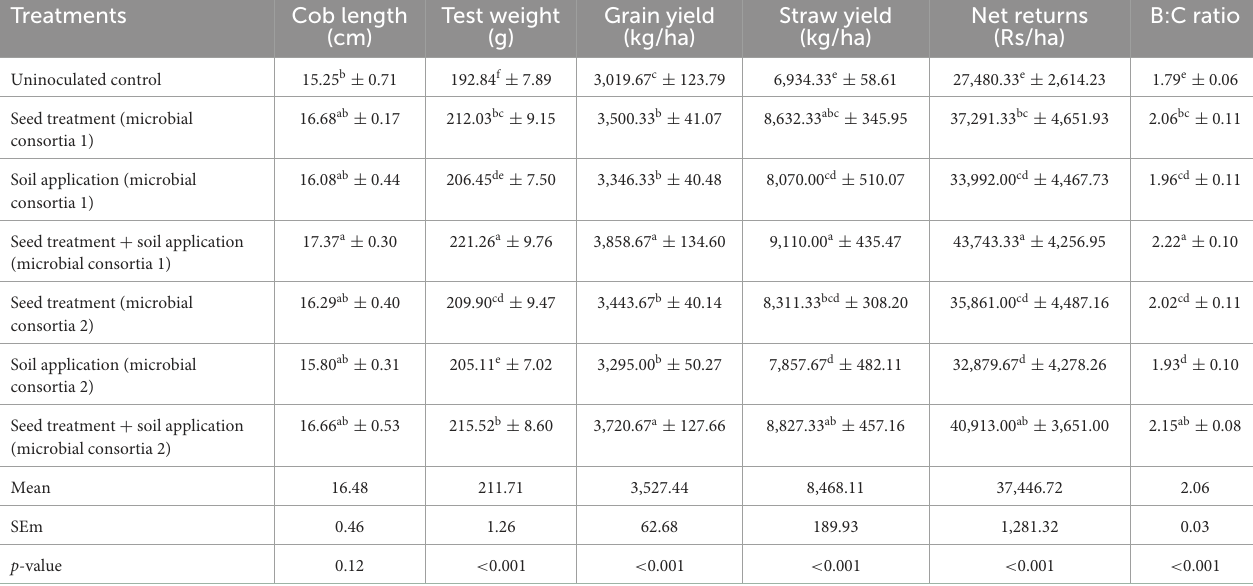
TABLE 3 Influence of seed and soil application of microbial consortia on yield attributes, yield, and economics of maize.